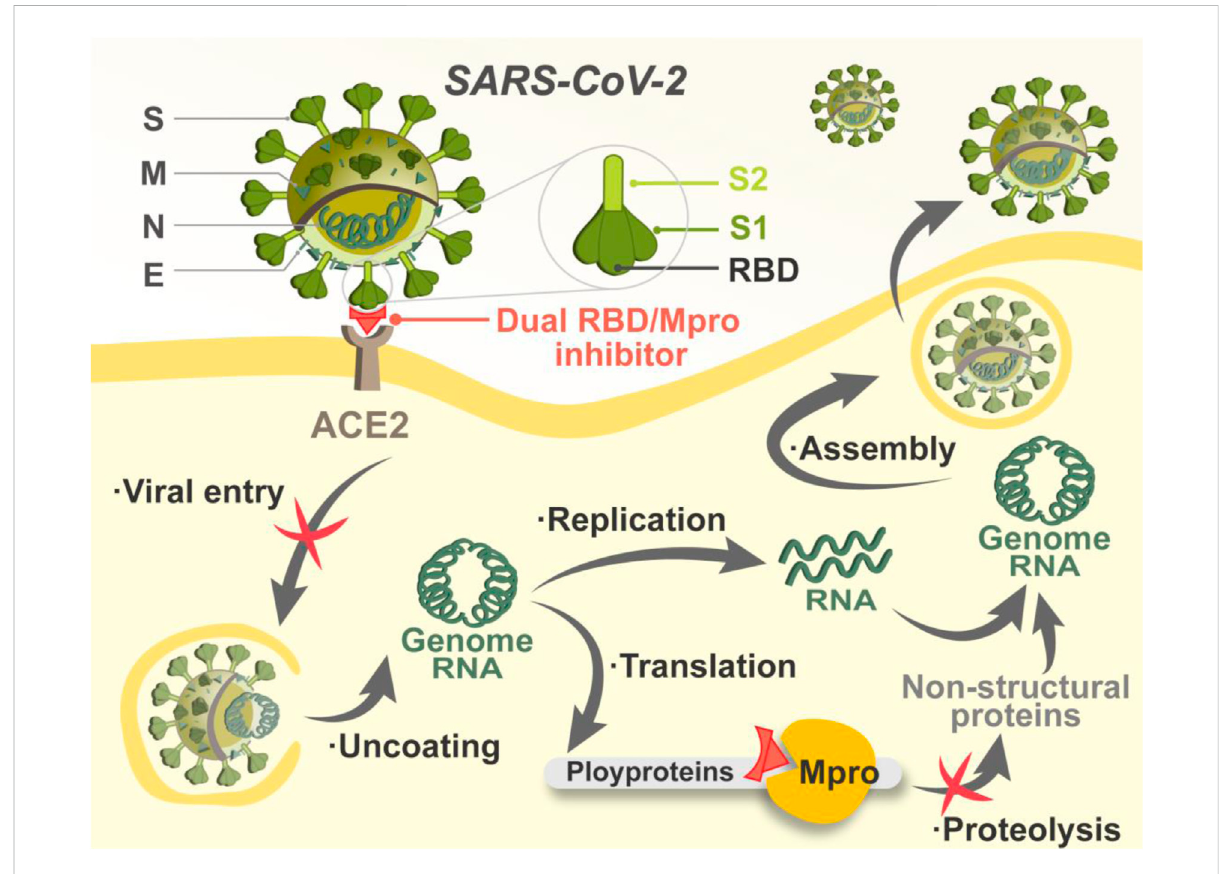
FIGURE 1 Schematic illustration of the mechanism of dual RBD/Mpro-targeting